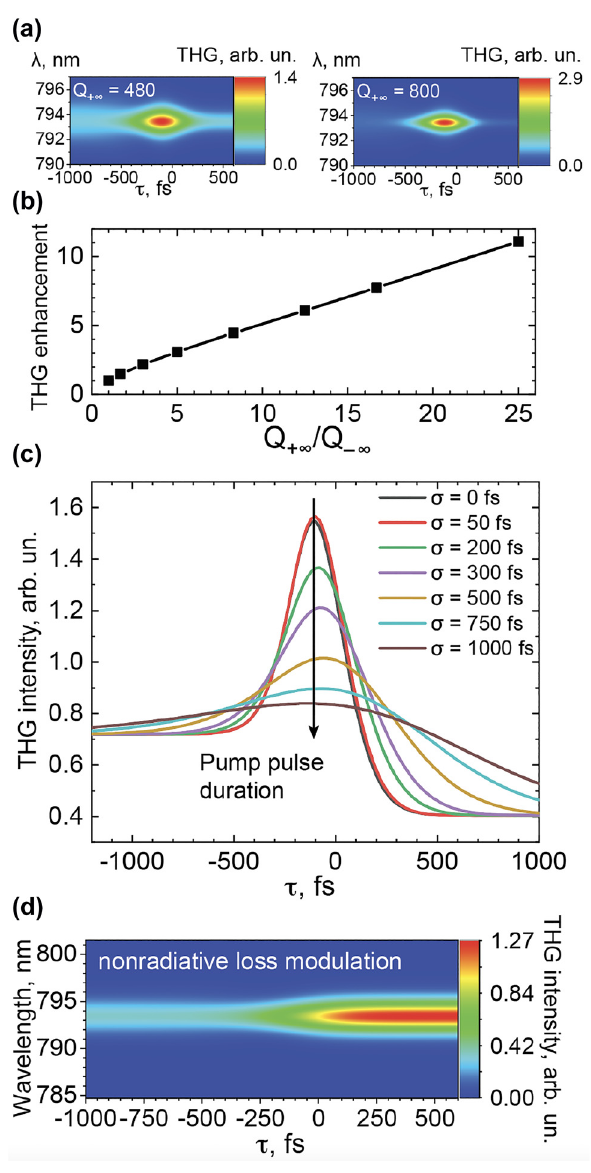
Figure 3: Third harmonic response. (a) Third-harmonic generation (THG) enhancement as a function of the final mode Q-factor ( Q +∞ ). Insets show THG spectra for = 480 and Q = 800. (b) Integral of the THG spectrum as a Q +∞ +∞ function of 𝜏 for a variety of Q-boost durations 𝜎 . (c) THG as a function of 𝜏 with static nonradiative losses and dynamic radiative losses. (d) THG as a function of 𝜏 with dynamic nonradiative losses and static radiative